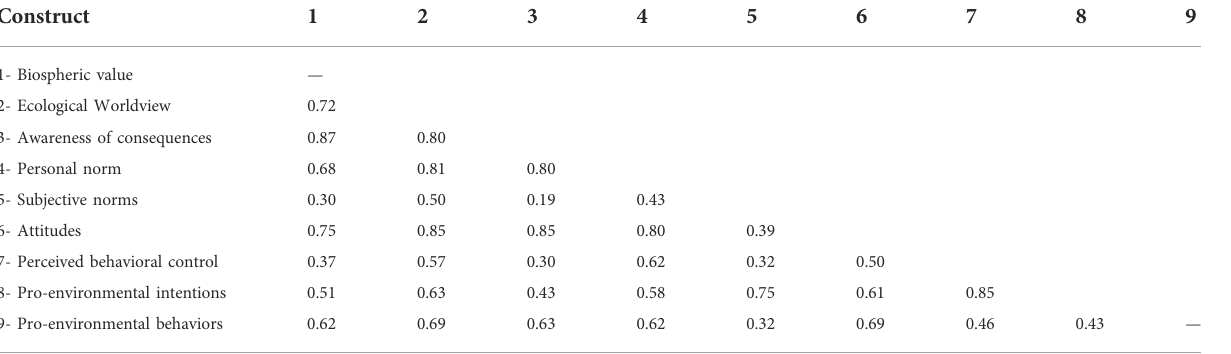
TABLE 3 Heterotrait-monotrait ratio of Correlation